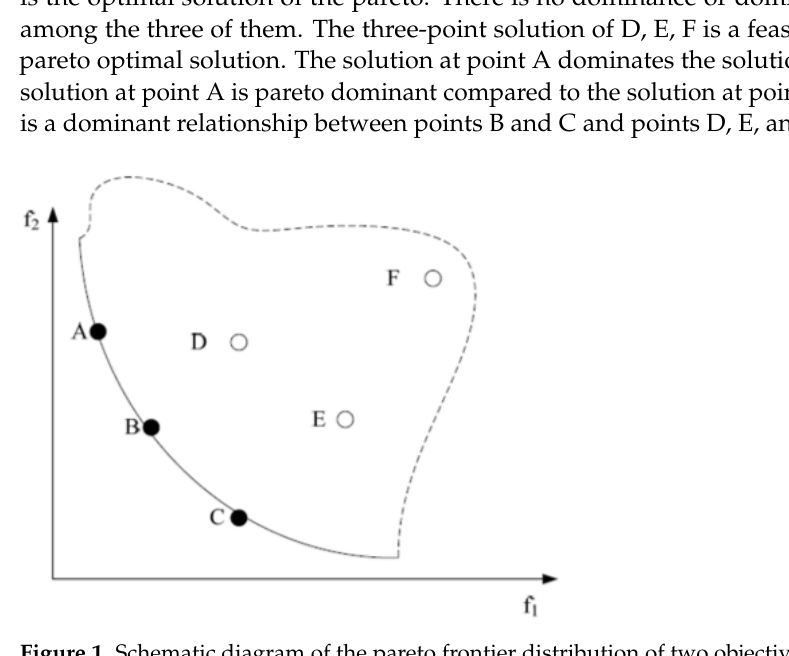
Table 2. Main parameters of propeller.